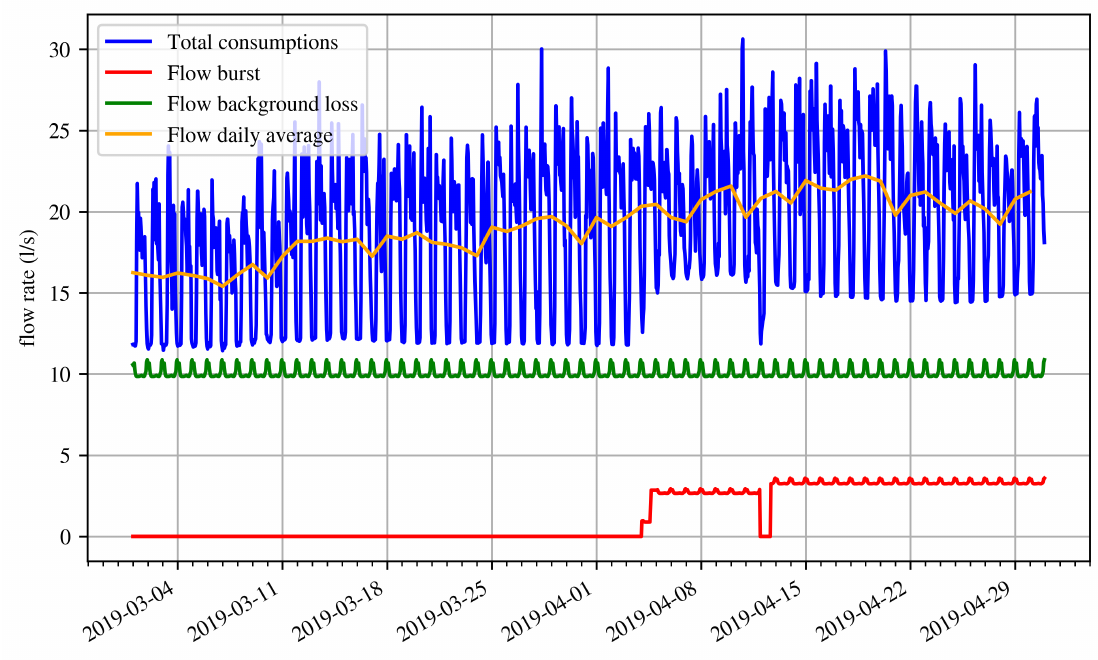
Figure 8. The decomposition of the metered flow rate of March and April for the Egna